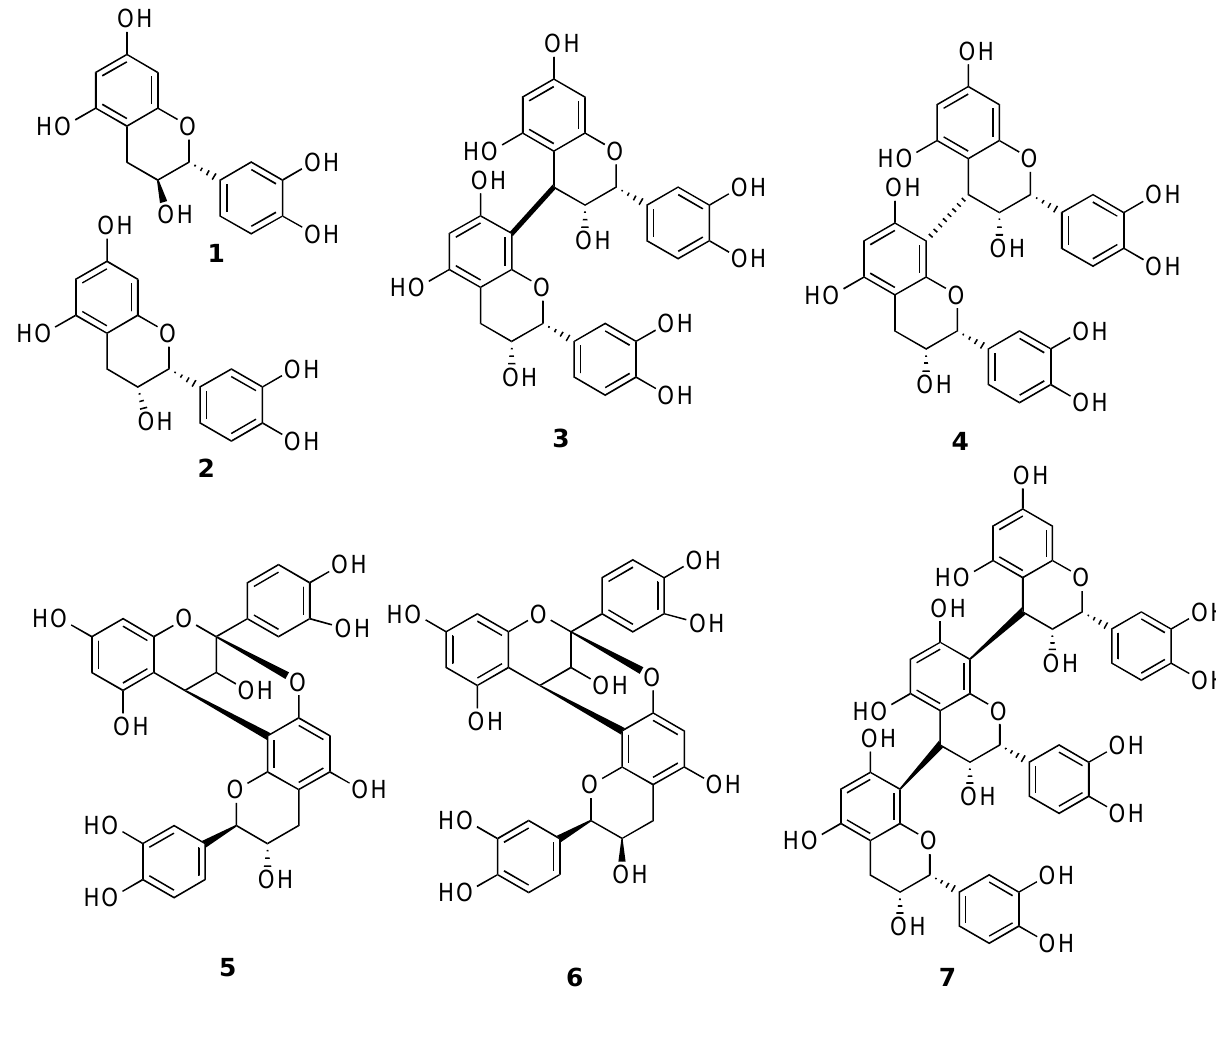
Figure 1 . Structures of